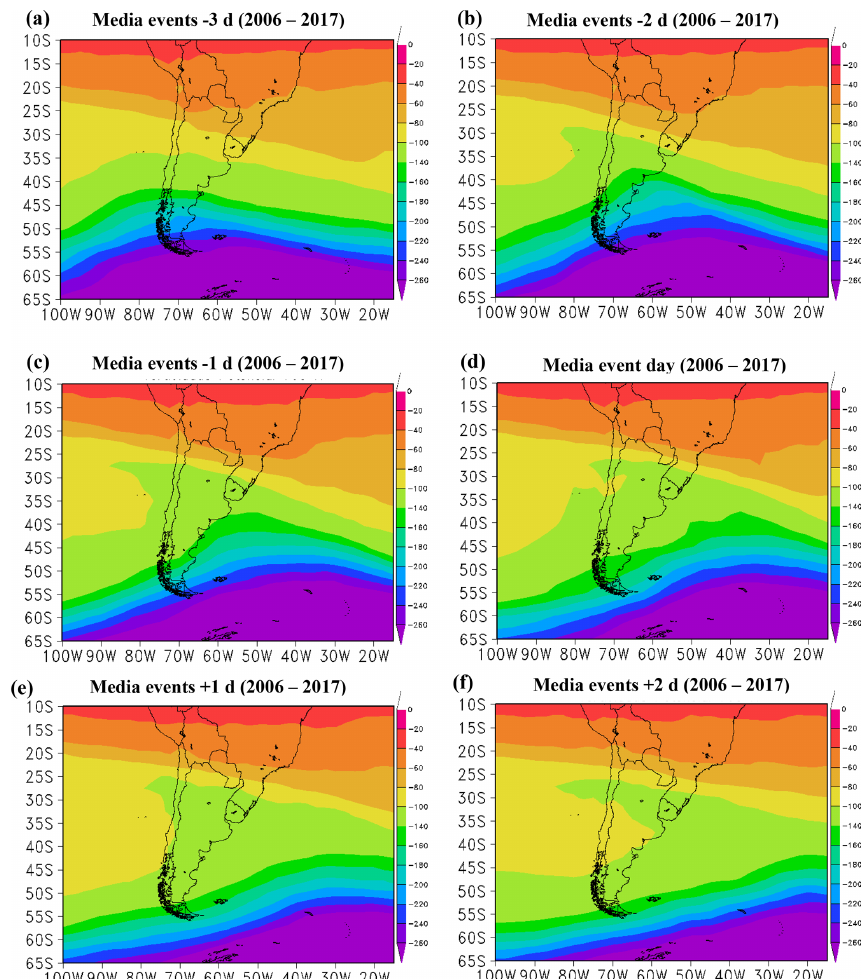
Figure 4. Average PV maps at the 700K isentropic level from 37 PV distributions detected as secondary effect events of AOH: (a) − 3d, (b) − 2d, (c) − 1d, (d) day of the event, (e) + 1d, (f) + 2d.